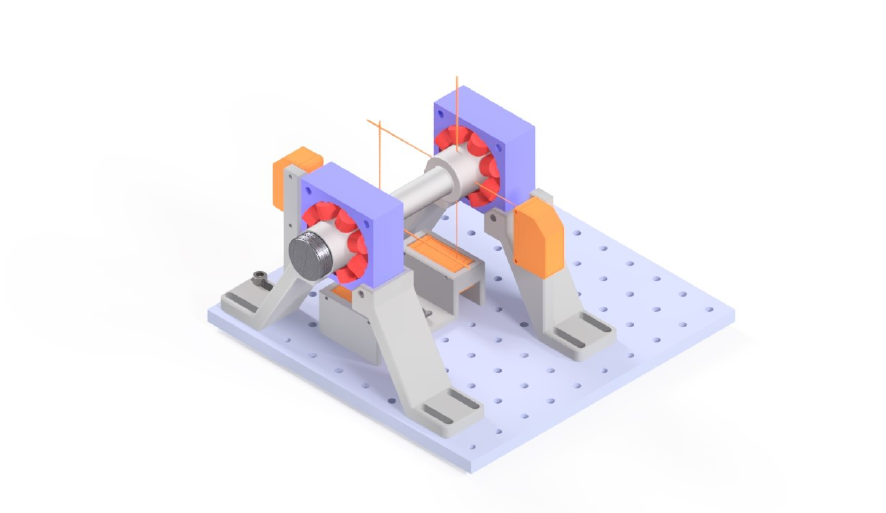
Figure 15. Three-dimensional model of the test bench with stator (blue), coils (red), rotor (light grey), sensors (orange), supports (grey) and base plate (grey).